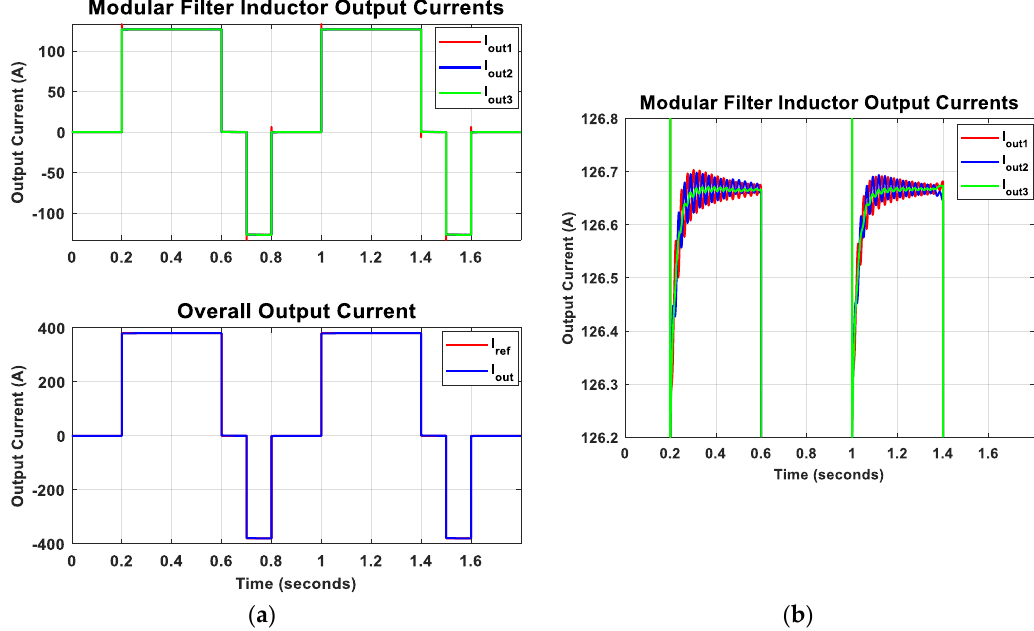
Figure 10. Simulation results for ISOS DC-DC converter: ( a ) modular filter inductor output currents and overall output current; ( b ) a zoomed-in illustration for the modular filter inductor output currents shown in ( a ).